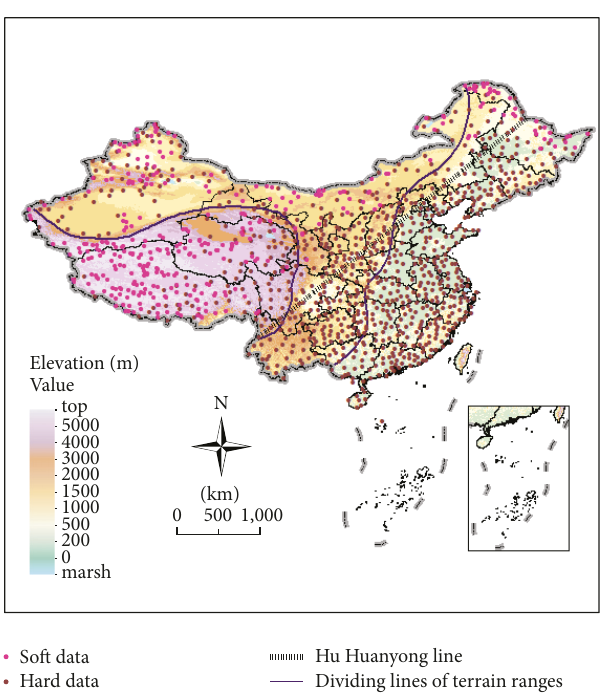
Figure 1: Map of the study area: provincial administration regions of Mainland China and the geographical locations of all 839 meteorological observation sites (brown dots) within it. These sites provide T a observations called hard data. The study area was di- vided into two parts: the west part and the east part with a dividing line (called Hu Huanyong line in the name of Chinese scholar Hu Huanyong). According to the elevation, three terrain ranges are demarcated (brown lines). The pink dots are supplemented loca- tions to calculate soft data (totally 334